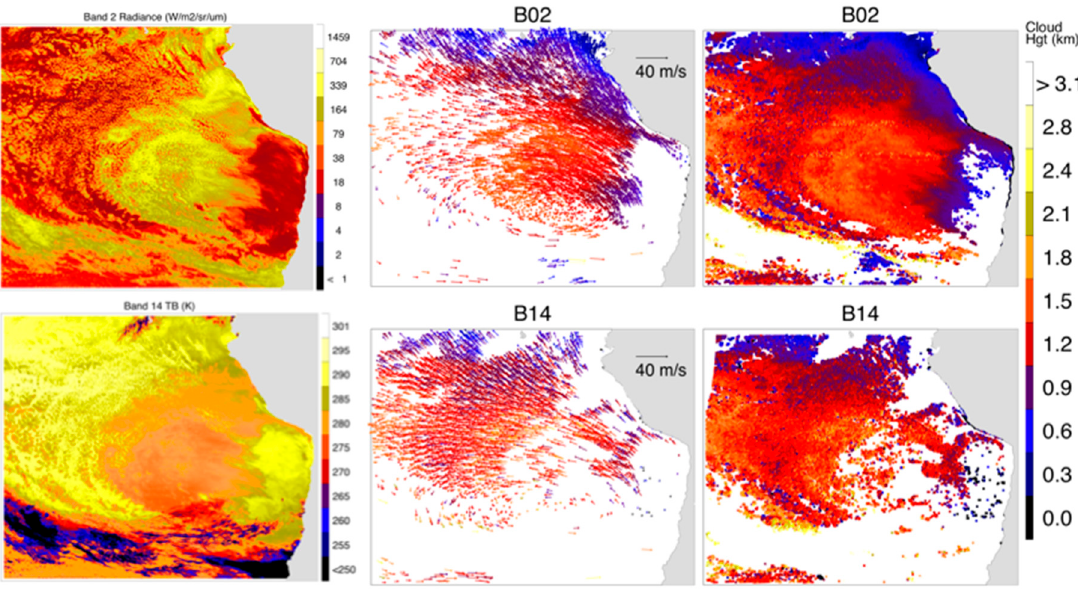
Figure 18. The stereo-wind retrievals using a template size of 12 pixels × 12 pixels from GOES-16 and -17 B02 ( top ) and B14 ( bottom ) in the Southeastern Pacific (SEP; 110° W–70° W,0–40° S) on 25 July 2020, 17:20 Z. For each band, the radiance map, along with AMV and stereo Cloud Top Height (CTH) retrievals are shown. The B02 radiances are in W/m 2 /sr/ μ m and B14 in brightness temperature (K). The AMV vectors are color-coded by CTH with sampling resolution indicated in the title of each panel. For illustration purposes, the AMV vectors are thinned by a factor of 64 for B02 and 8 for B14 in the